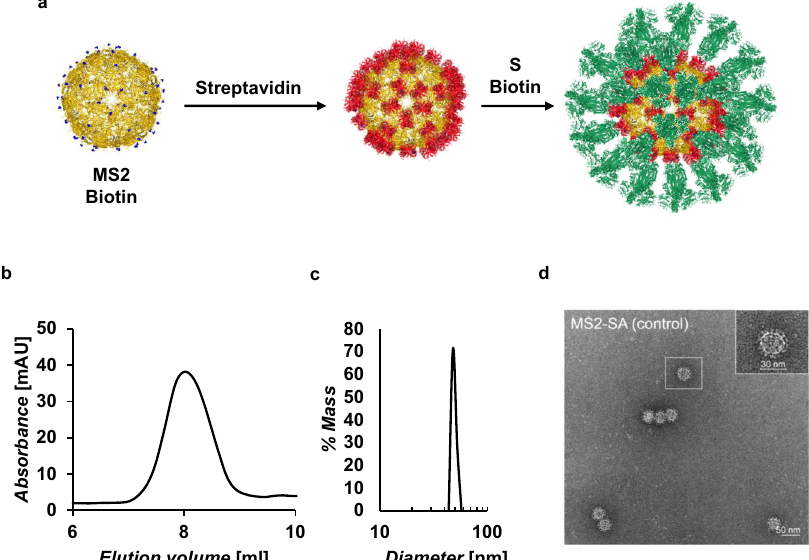
Fig. 1 Assembly of VLP-S and characterization of MS2-SA VLP. a Scheme illustrating assembly of VLP-S, where biotinylated MS2 (yellow, PDB: 2MS2) is added to streptavidin (red, PDB:3RY2) to create the VLP. S (green, PDB: 6VSB) biotinylated at the C-terminus is mixed with the VLP to create VLP-S. Biotinylated residues are colored blue. b Size exclusion chromatography trace for MS2-SA VLP. The column void volume is 7.2 mL. c Characterization of the